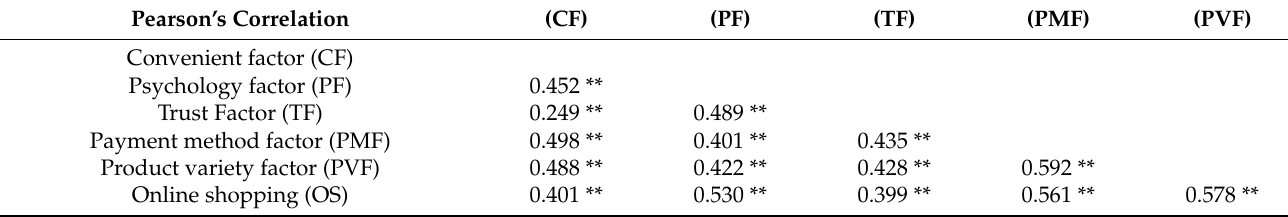
Table 4. Pearson’s correlation coefficient (r) (N =